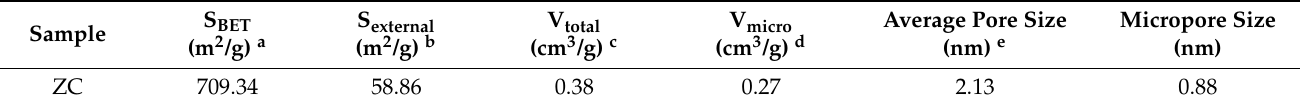
Figure 9. Pore size distribution of ZC. Table 4. Textural properties of ZC sample.